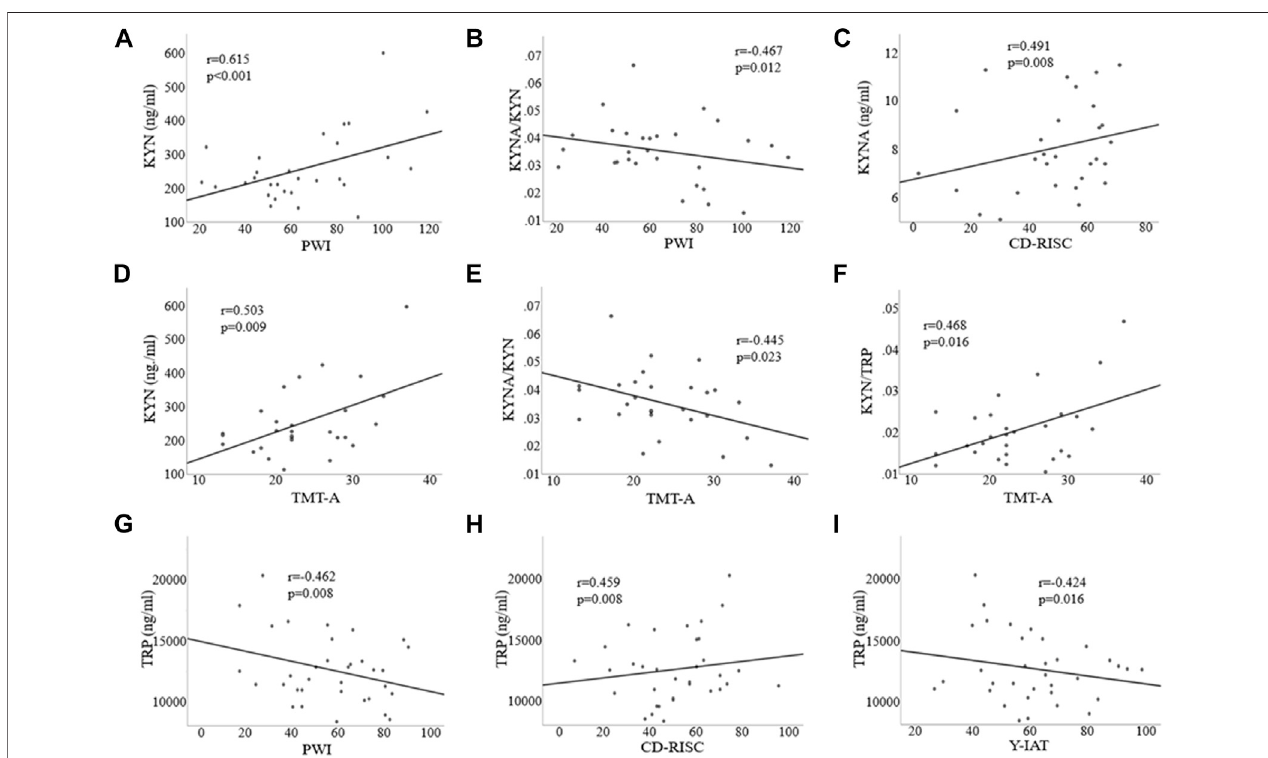
FIGURE 4 | Correlations among clinical, executive function, and kynurenine pathway metabolite variables in the alcohol use disorder (A – F) and Internet gaming disorder (G – I) groups. TRP, Tryptophan; 5-HT, 5-hydroxytryptamine; KYN, Kynurenine; KYNA, Kynurenic acid; Y-IAT, Young ’ s Internet Addiction Test; PWI, Psychosocial Well-Being Index; CD-RISC, Connor-Davidson Resilience Scale; TMT-A, Trail Making Test-A.